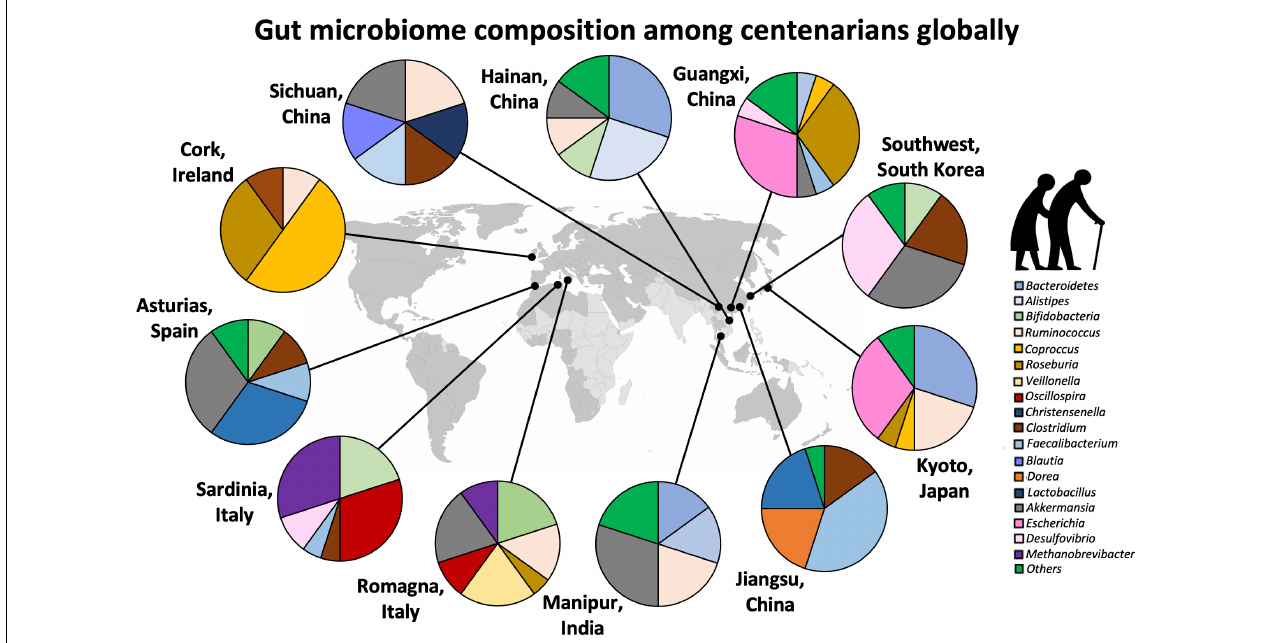
FIGURE 4 | Centenarians harbour distinct gut microbial species and community structures unique to the region, suggesting that microbial functional and biochemical properties are pivotal to healthy ageing, rather than the phylogenetic composition. Data adapted from Claesson et al. (2012), Fang et al. (2015), Biagi et al. (2016), Kong et al. (2016), Bian et al. (2017); Bong-Soo et al. (2019), Naito et al. (2019), Salazar et al. (2019), Tuikhar et al. (2019), Wu et al. (2019), and Luan et al.